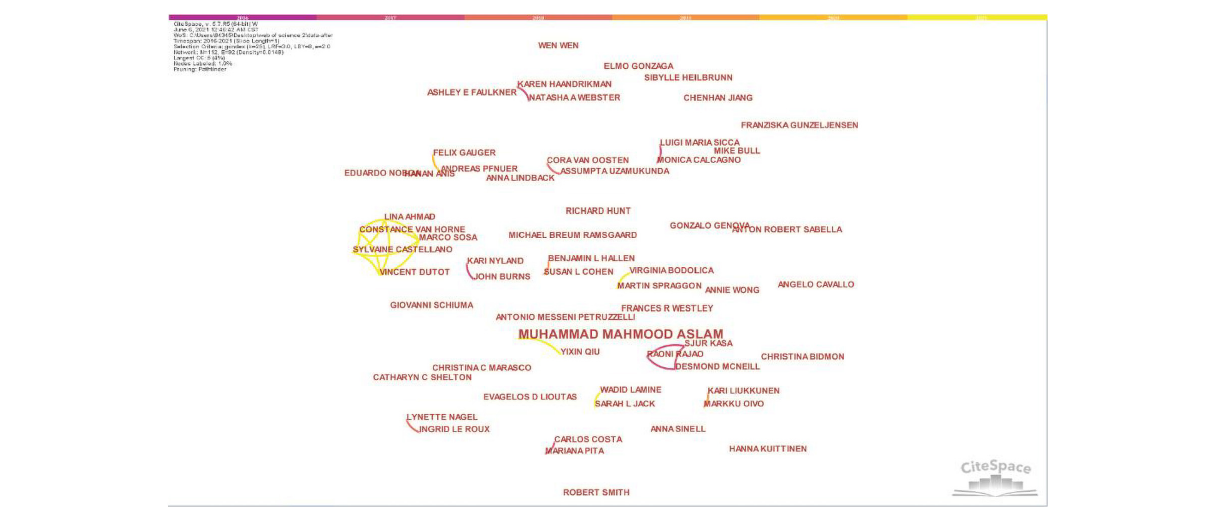
Frontiers in Psychology |